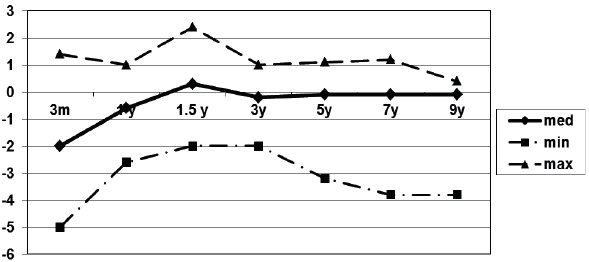
Fig. 2. Body height (SDS) in comparison with the standard Czech population (0 level) in 3 months, 1 year, 1.5 years, 3, 5, 7 and 9 years.